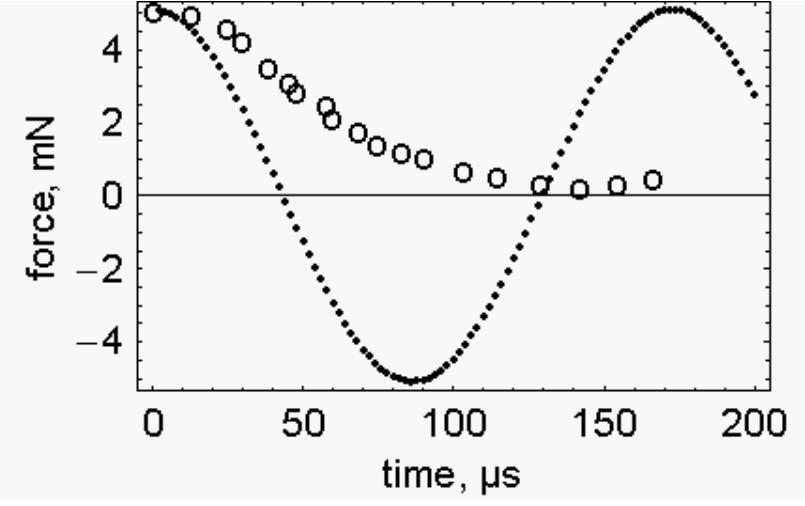
Figure 3. Time course of the force during a quick release – Observed change of force during a quick release of 6 nm/half sarcomere (open circles). Calculated change of force during the same release (filled circles). The conditions used for the calculation were those , = 270 kN/m 2 ; fibre length, 5.34×10 -3 m; fibre section, of Figure 14 of Ford et al . [2]: P 0 1.89×10 -8 m 2 ; fibre density (corrected for the markers), 1.19×10 3 Kg/m 3 ; sarcomere length, 2×10 -6 m; fibre stiffness, 0.015927